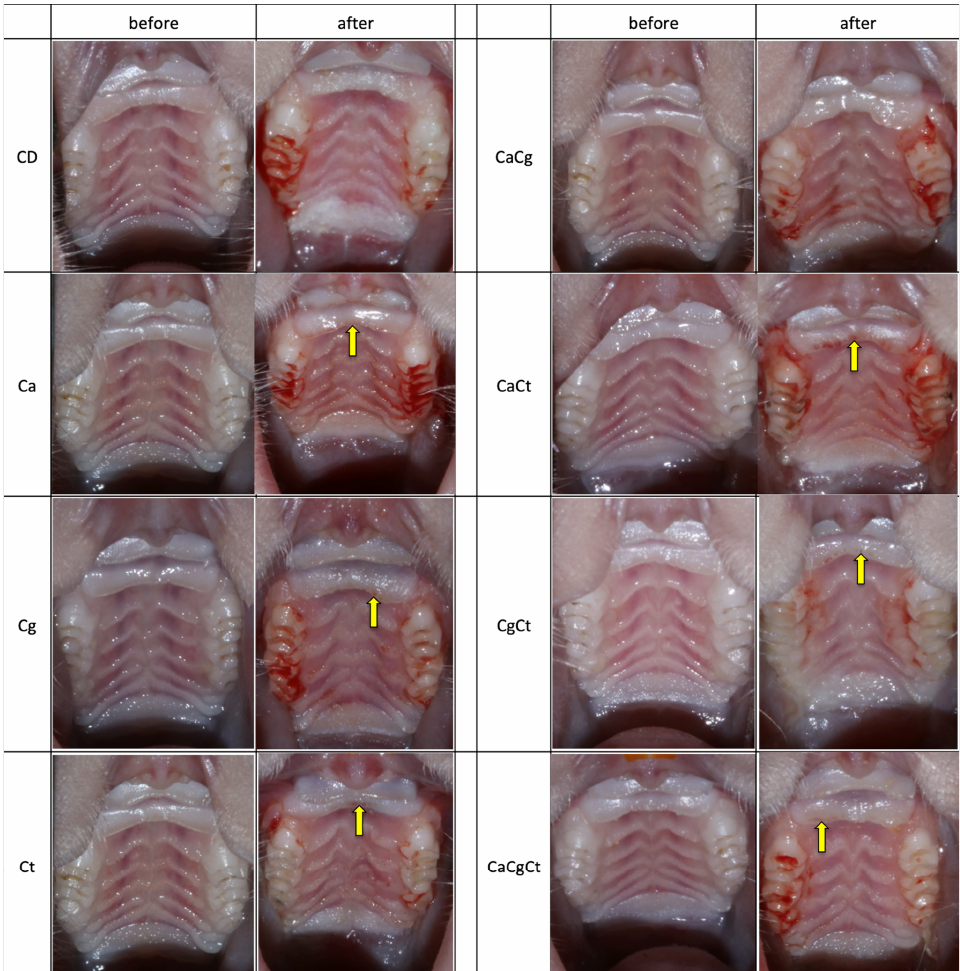
Figure 4. Photographs of the palate of female rats before (day 0) and after (day 42) the 4-week period with the acrylic device. In each group, both photographs (before and after) are from the same animal. The yellow arrows show red spots on the anterior papillae. CD: device control, Ca: Candida albicans , Cg: Candida glabrata , Ct: Candida tropicalis , CaCg: C. albicans + C. glabrata , CaCt: C. albicans + C. tropicalis , CgCt: C. glabrata + C. tropicalis , and CaCgCt: C. albicans + C. glabrata + C. tropicalis groups.